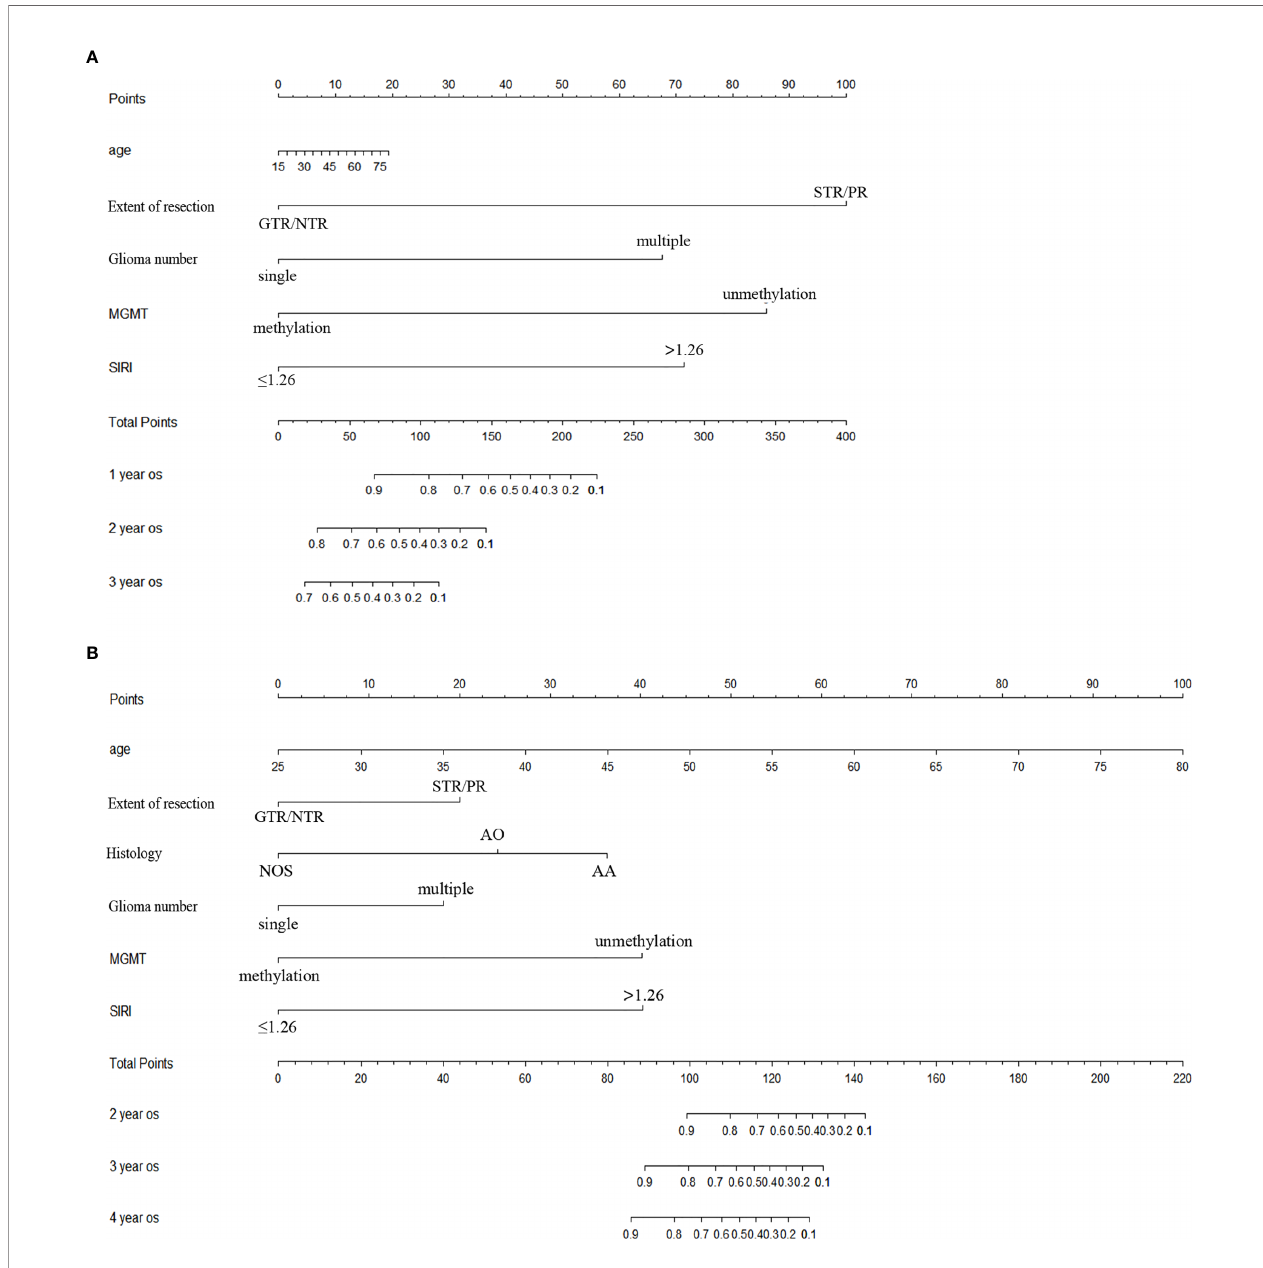
FIGURE 4 | The nomogram (A) covering age, extent of resection, number of glioma, MGMT methylation status and SIRI at 1-year, 2-year and 3-year in operable grade IV glioma patients and (B) covering age, extent of resection, histological type, number of glioma, MGMT methylation status and SIRI at 2-year, 3-year and 4- year in operable grade III glioma